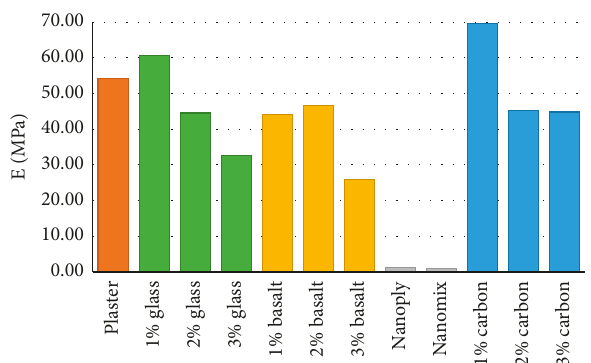
Figure 1: Comparison of Young’s modulus of the Thermo UM lime-cement plaster with various types of